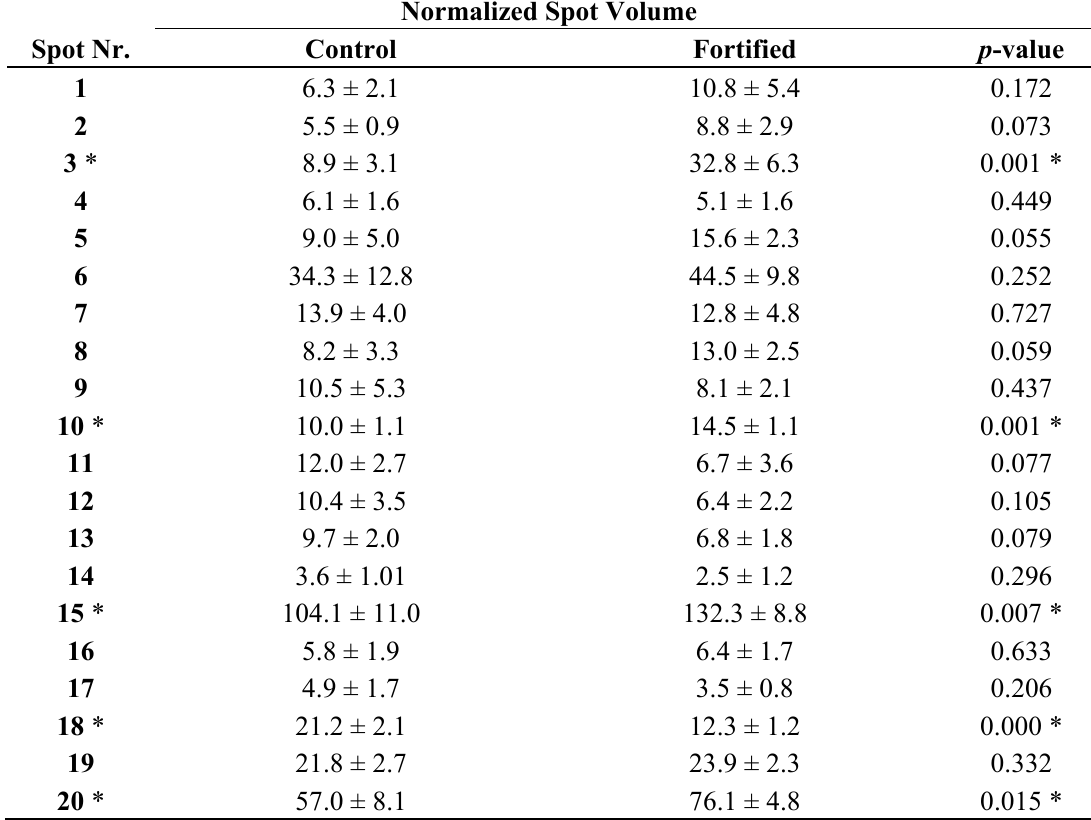
Molecular mass ladder and pH scale are indicated. The valid spots are numbered in the figure. Gels were made in quadruplicate. Table 1. Normalized spot volume (Means ± standard deviation) and statistical comparison (Student’s t Test) between fortified and control plants. Spot